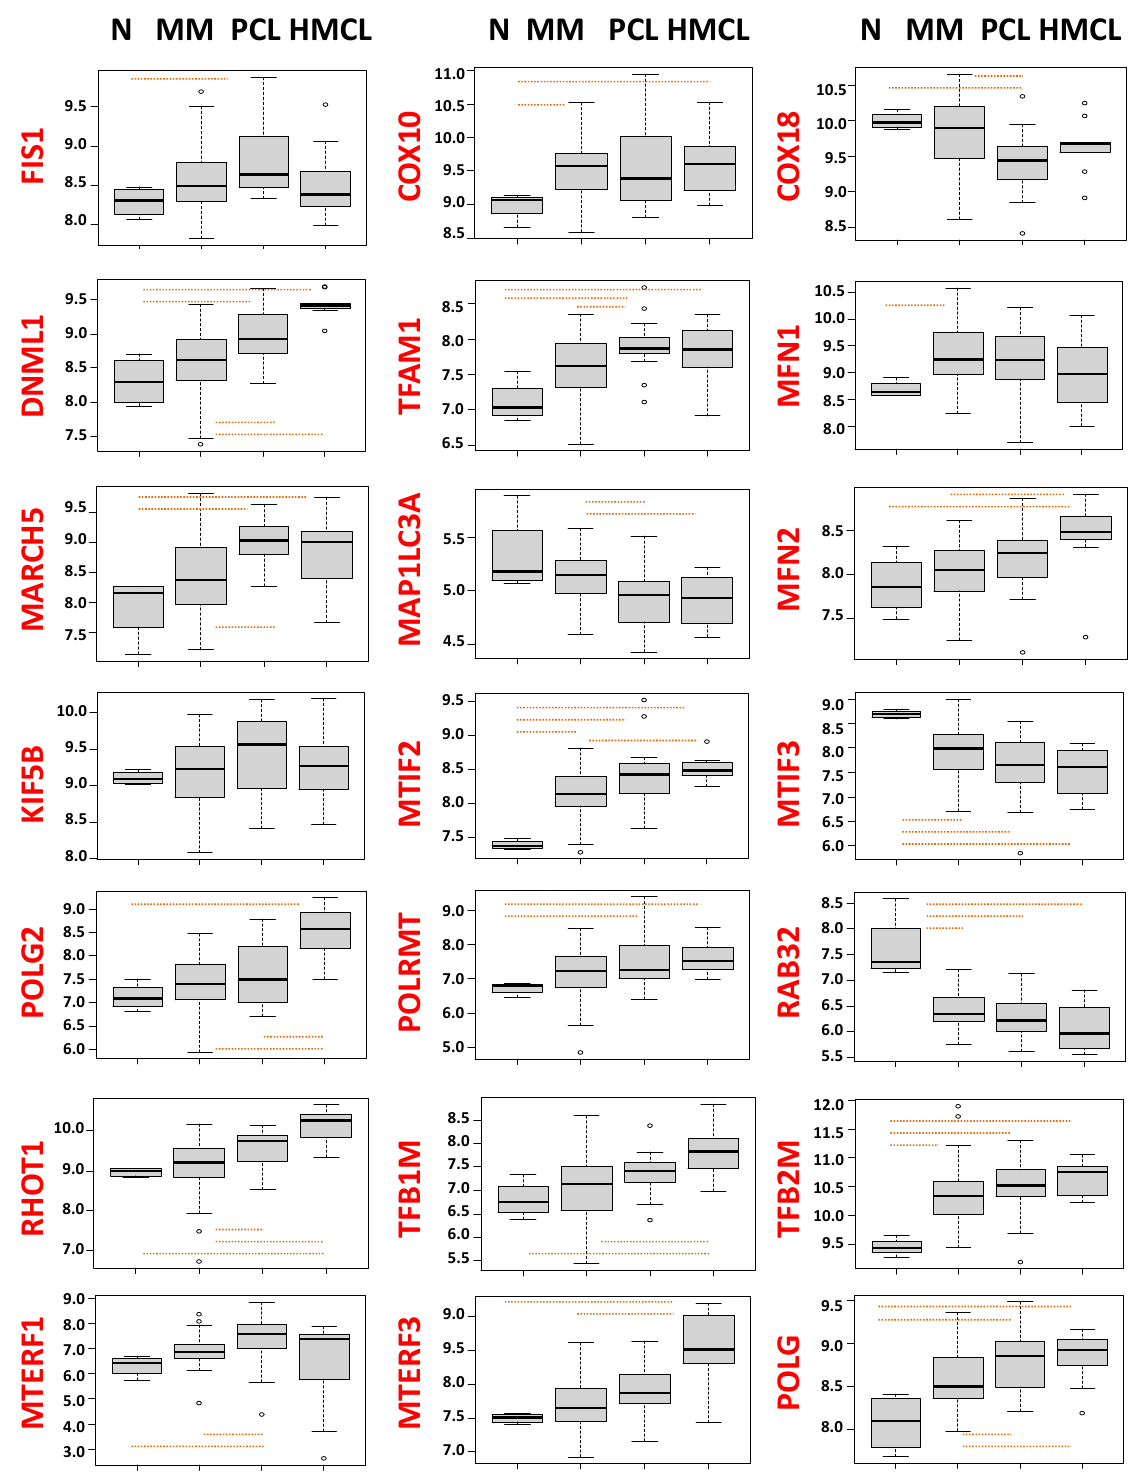
Figure 1. Box plot representation of the mRNA expression of mitochondrial quality control genes, in four normal control (N), 50 multiple myeloma (MM) patients, 15 primary plasma cell leukemia (PCL), and 10 human myeloma cell lines (HMCLs) evaluated by GeneChip ® Human Gene 2.0 ST array (GSE 116294). In each panel, orange dashed lines indicate significant differences between groups based on Dunn’s test ( p -value <